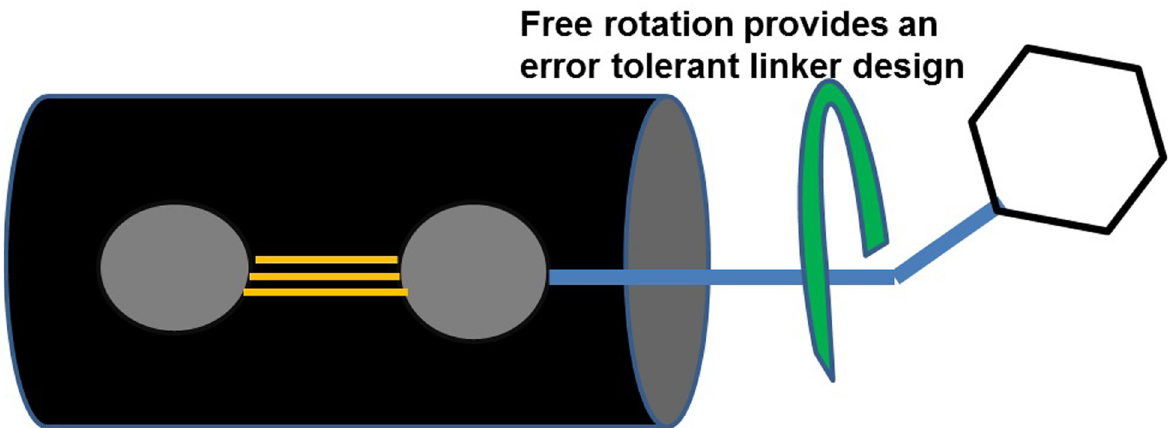
Fig 10. Direct single bond linkage to a triple bond enables penalty-free complete 360˚ dihedral rotation. A group terminally attached to an acetylene linker can freely align to match the contours of PCSK9 in this region and simultaneously present polar hydrogen to PCSK9 D374 to pincer this key